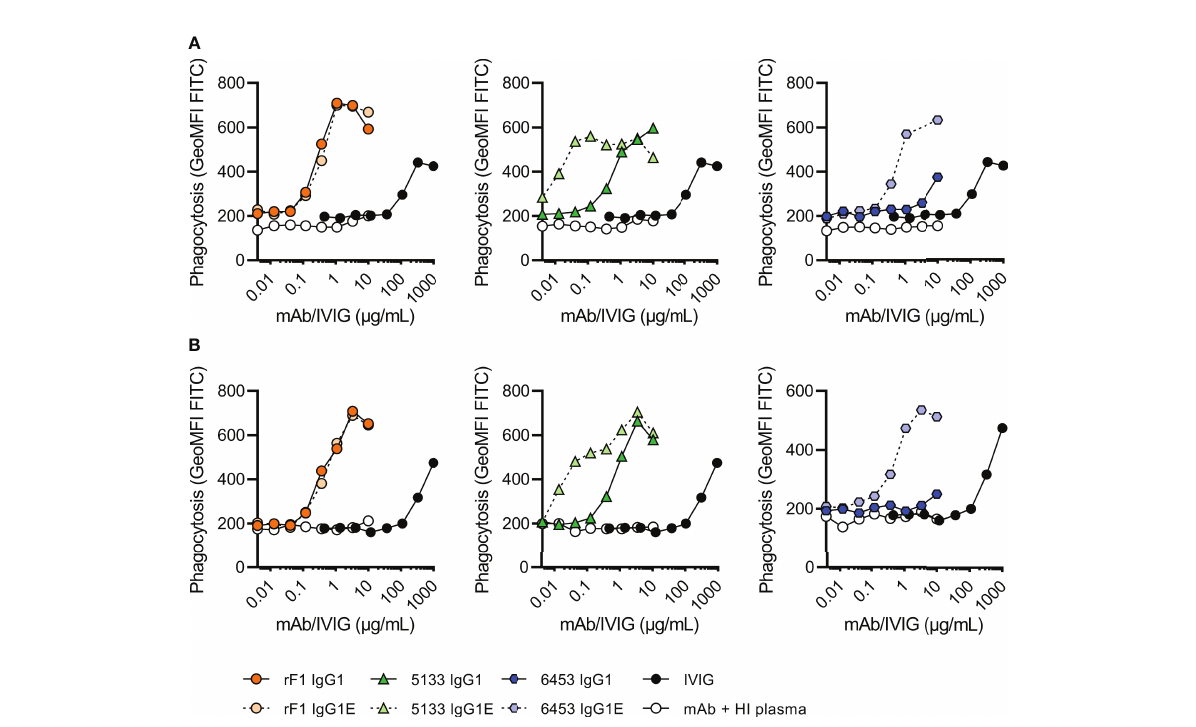
FIGURE 5 Phagocytosis of FITC labelled N2297 after incubation with mAbs or IVIG in 1% neonatal plasma. Phagocytosis of S. epidermidis N2297 by human neutrophils (MOI 10:1) in (A) a representative donor of 32-37 weeks GA and (B) a representative donor >37 weeks GA. FITC labelled bacteria were incubated in 1% neonatal plasma or 1% HI neonatal plasma supplemented with a concentration range of rF1, CR5133 or CR6453 IgG1 or IgG1 E345K or IVIG. Phagocytosis was quanti fi ed by fl ow cytometry and plotted as FITC GeoMFI of the neutrophils population. Data represent data of one independent experiment. Additional donors (n=5) can be viewed in Figure S5. GA, Gestational